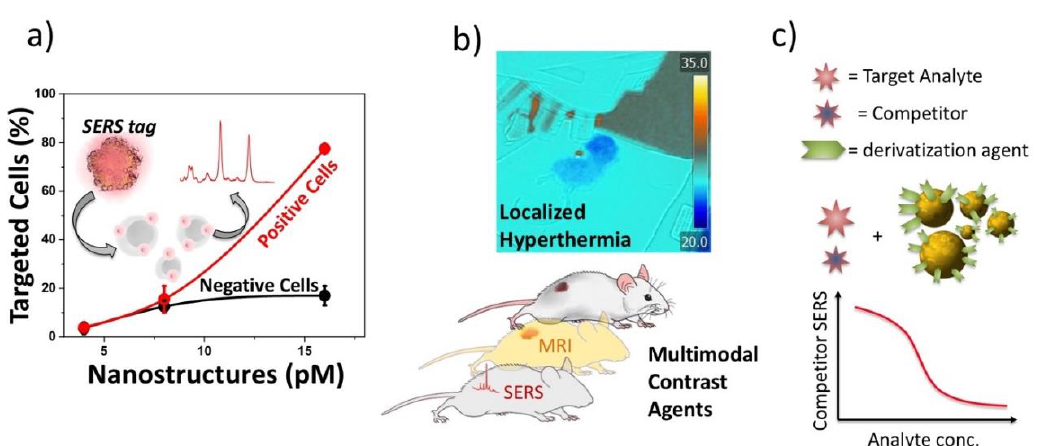
Figure 17. Nanoparticles obtained by LAL are particularly versatile for biotechnology applications. ( a ) active antigen targeting of cells overexpressing or not the antigen using Surface Enhanced Raman Scattering (SERS) signals; ( b ) multimodal contrast agents and hyperthermal experiments; ( c ) therapeutic drug monitoring with a competitive SERS protocol.